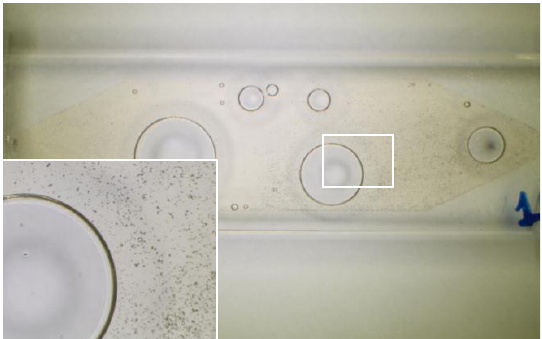
Figure 9. General (0.8 × ) and detailed view (2 × ) of the 0.5 mm quartz cuvette containing the contaminated lubricant sample and air bubbles.